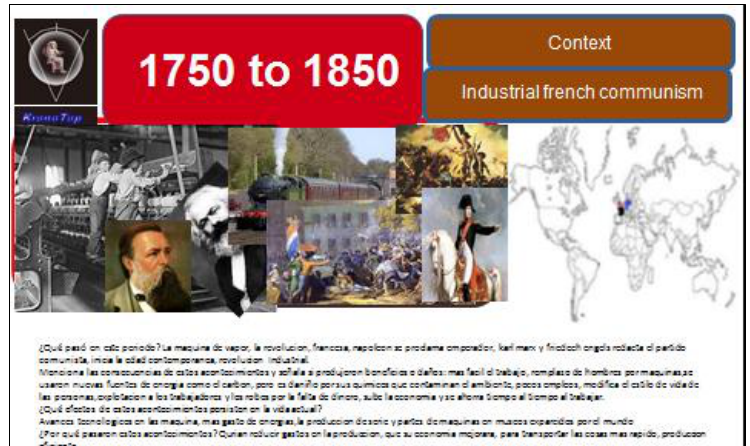
Figure 8 . Use of digitized sources and spatial location of historical events in the period from 1750 to